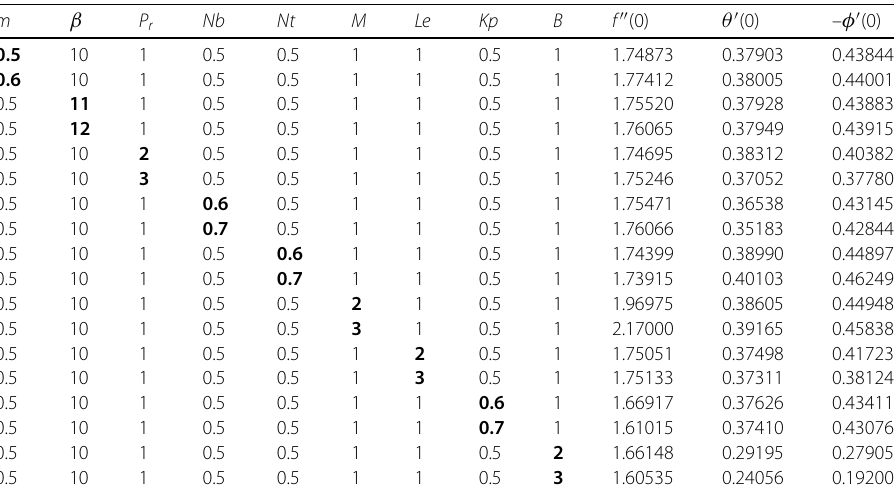
Table 2 Variation of skin friction, Nusselt and Sherwood numbers for different parameters. In this table, the boldface values specify that we are increasing the values of those particular physical parameters keeping the values of other parameters